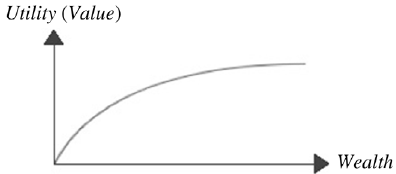
Figure 1. Diminishing Marginal Utility of